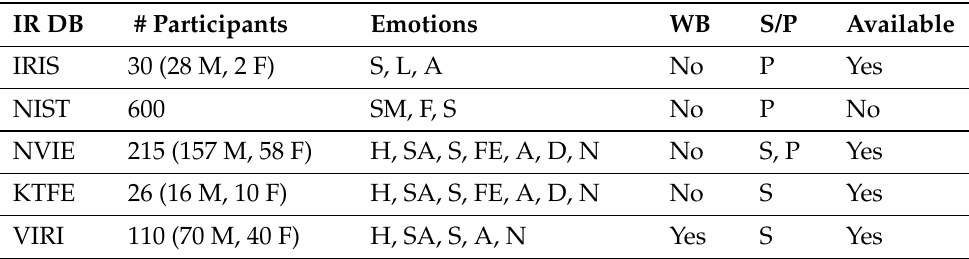
Table 6. Comparison of the available IR DBs and